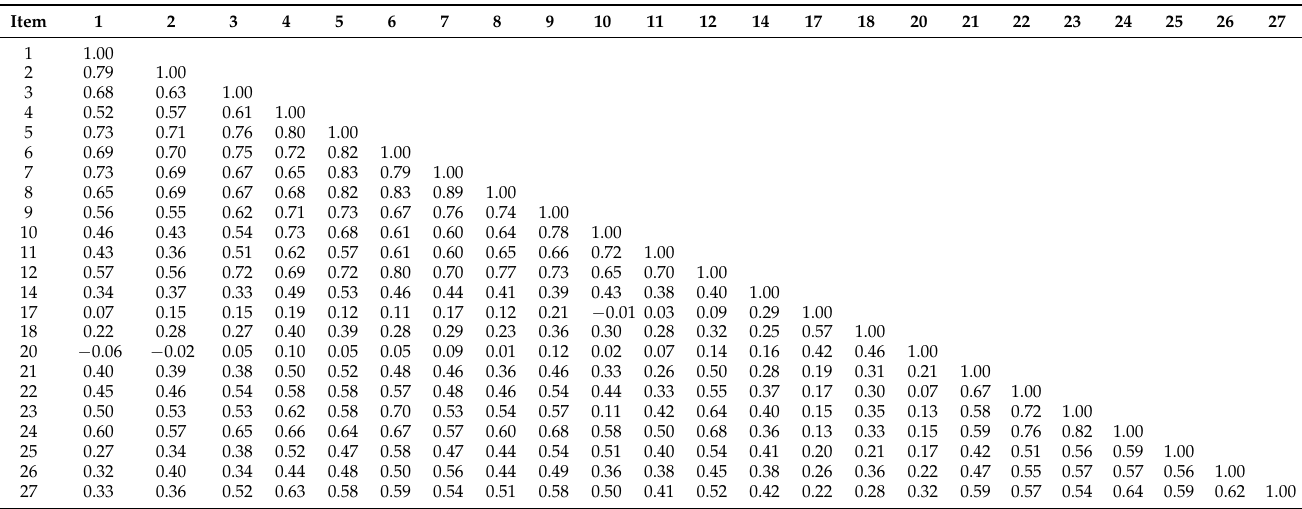
Table 3. Polychoric correlation matrix.